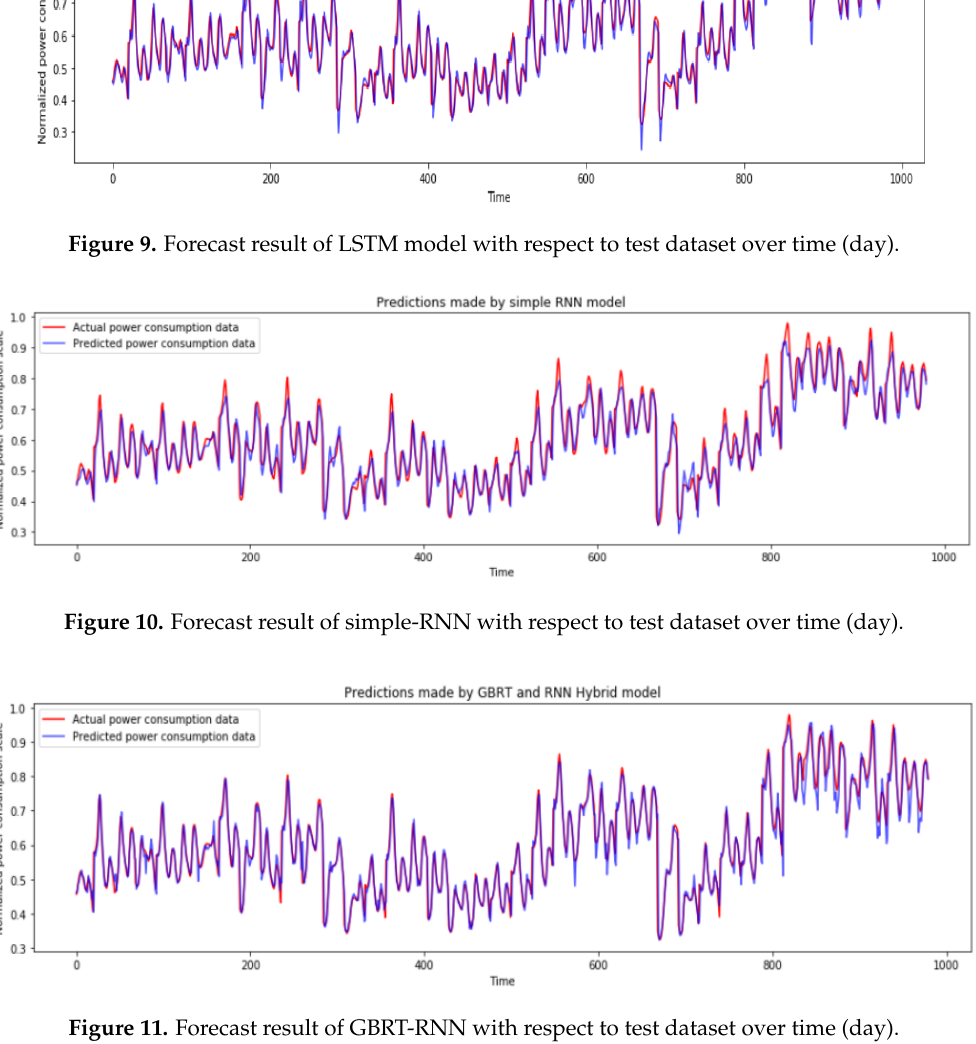
Figure 11. Forecast result of GBRT-RNN with respect to test dataset over time (day).